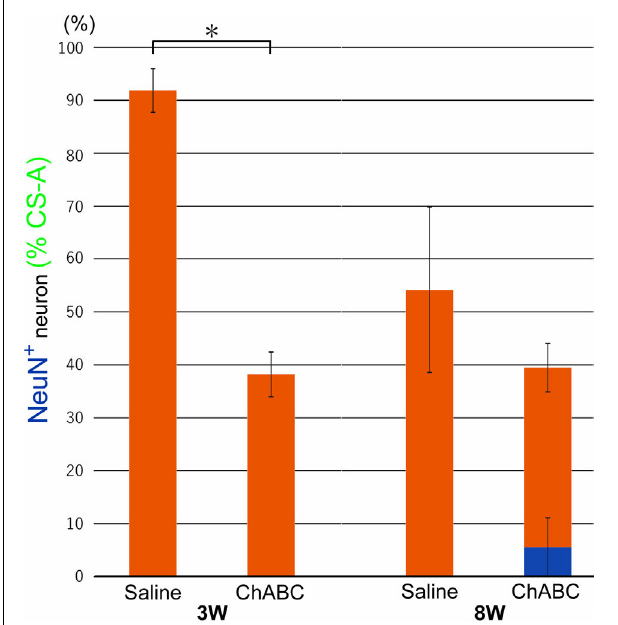
FIGURE 5 | Percentages of motoneurons whose cell bodies were covered with CS-A-positive perineuronal net (PNN) structures among all motoneurons at 3 and 8 weeks after CST in rats with ChABC or saline administration. The blue bar indicates the percentage of motoneurons with > 80% CS-A-positive structures and the red bars indicate the percentage of motoneurons with > 20% CS-A-positive structures. Data are expressed as the mean ± SEM. Significant differences are indicated by ∗ ( p <